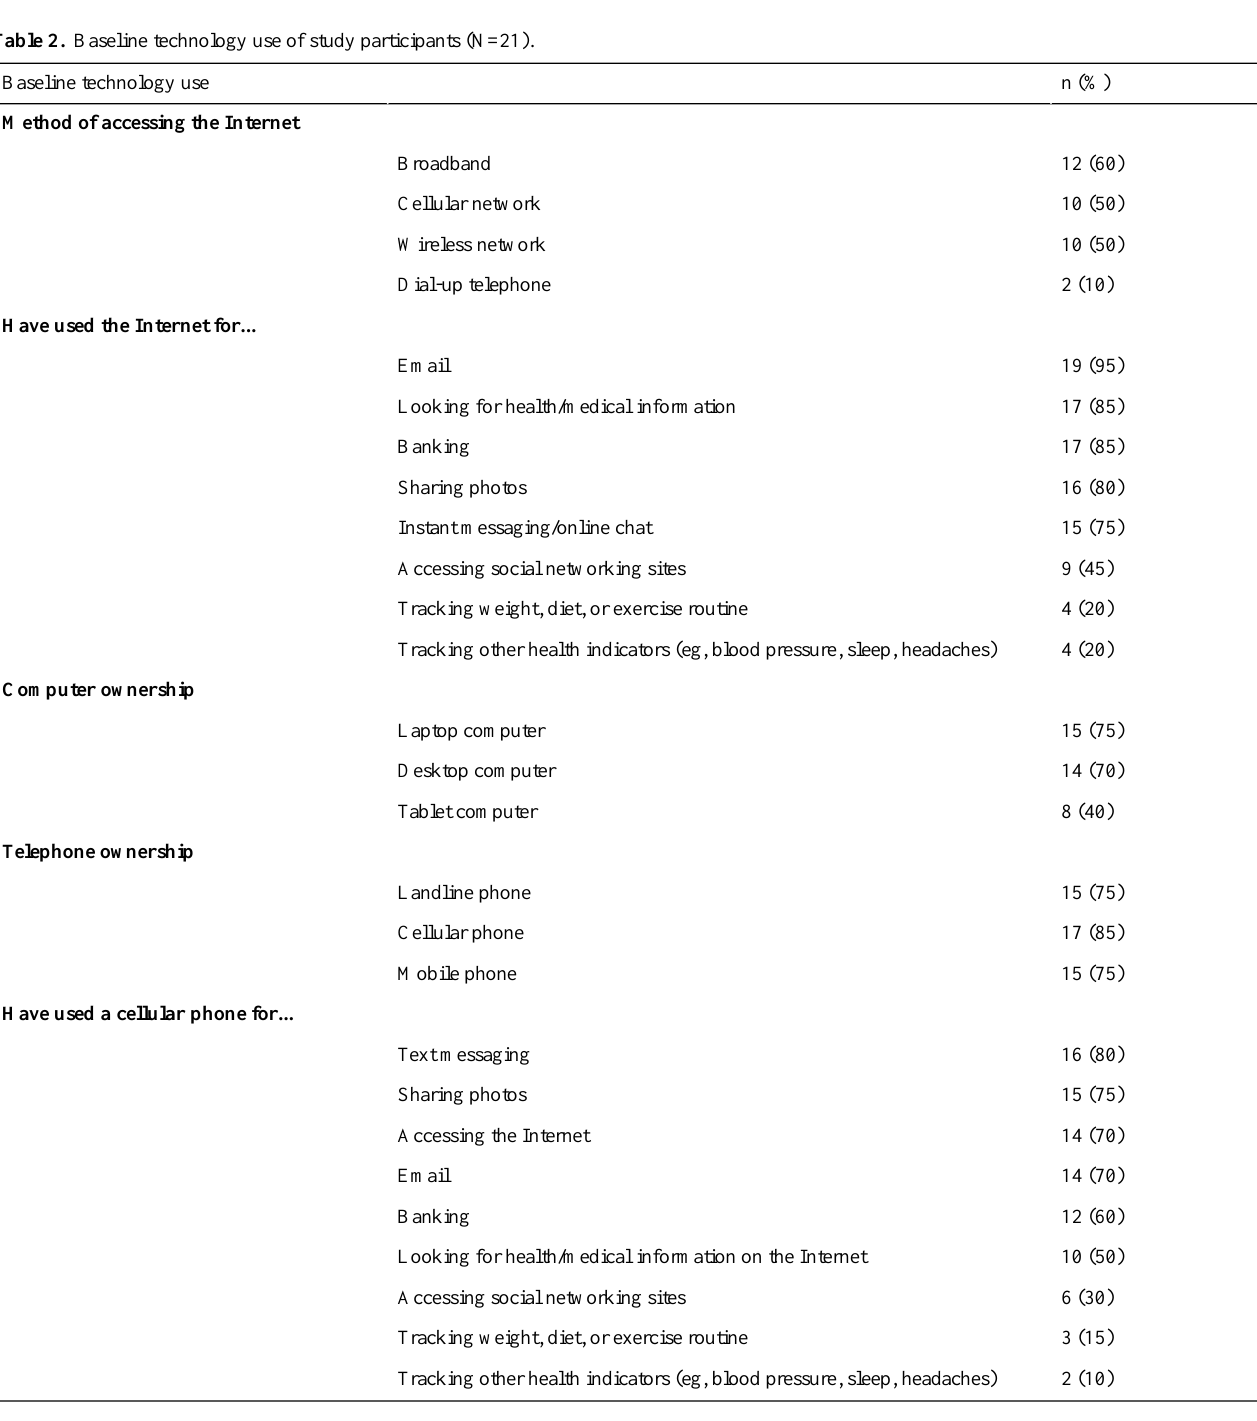
Have used a cellular phone